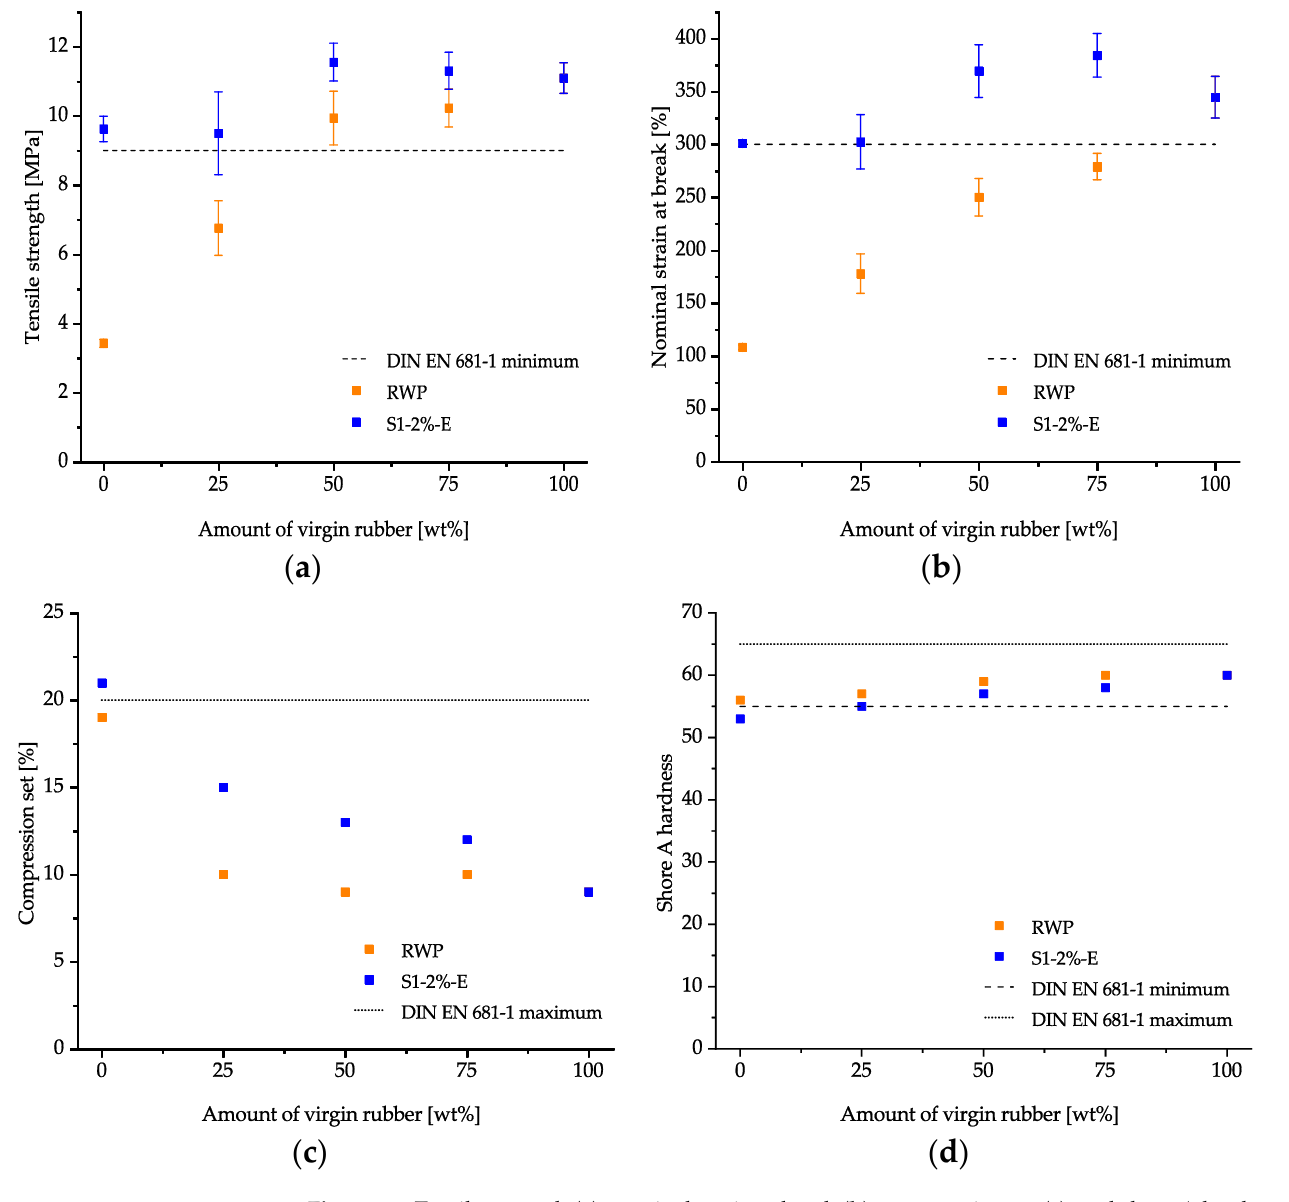
Figure 10. Tensile strength ( a ), nominal strain at break ( b ), compression set ( c ), and shore A hardness